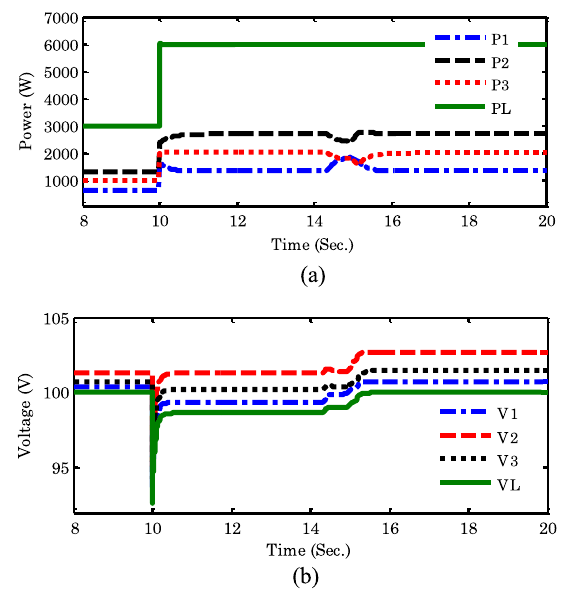
Fig. 9 Performance of the proposed primary control approach and the secondary control without communication link, ( a ) Output power of the converters and load power, ( b ) Output voltages of the converters and load voltage